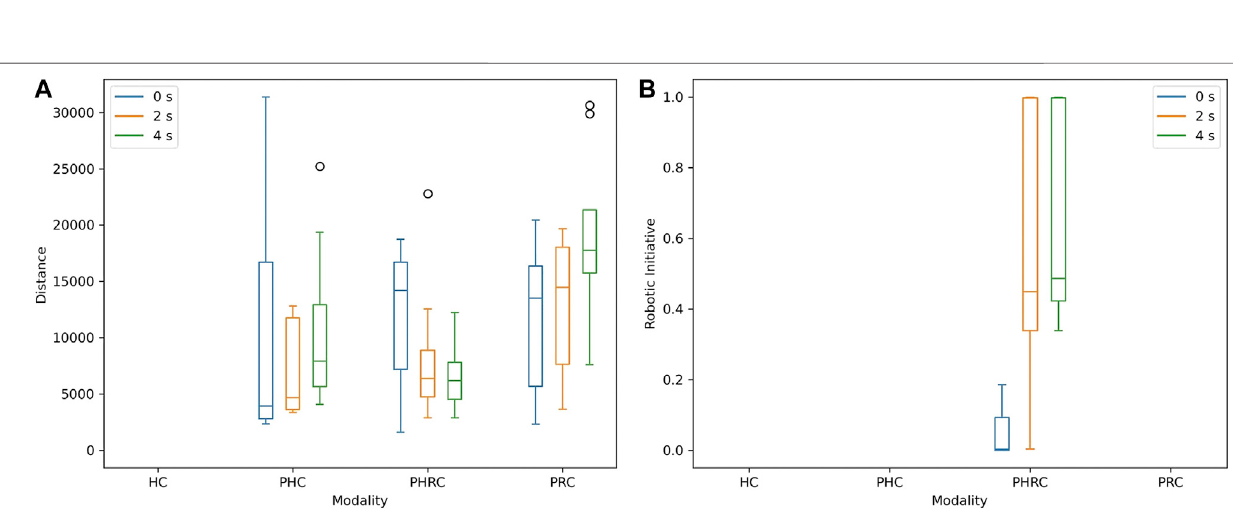
Frontiers in Robotics and AI |